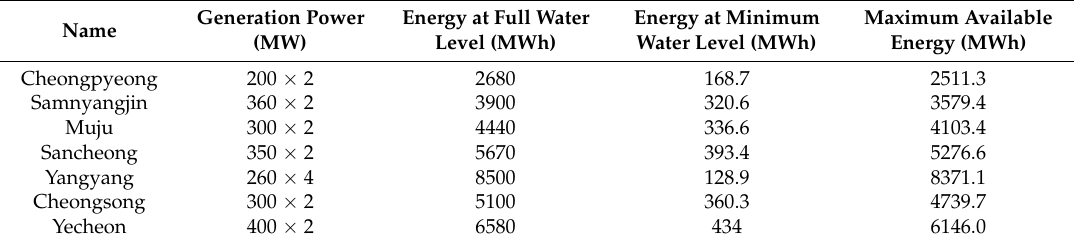
Table 1. Basic pumped hydroelectric storage (PHES) information in Korea.